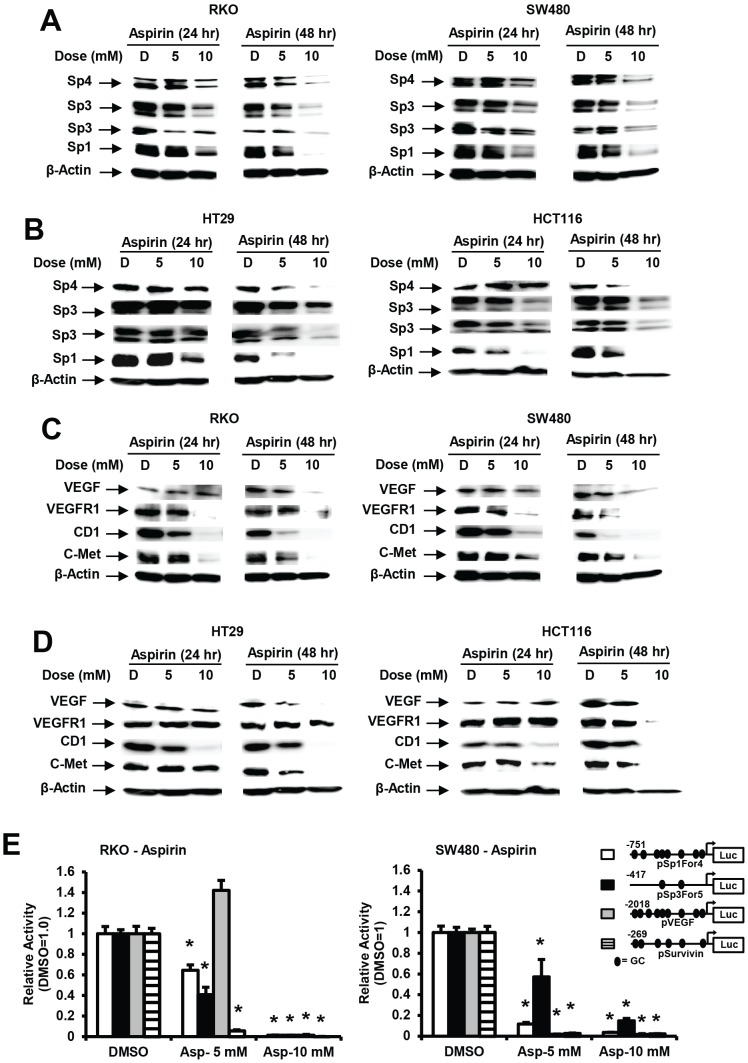
Aspirin decreases expressions of Sp1, Sp3, Sp4 and Sp-regulated gene products in colon cancer cells.Downregulation of Sp proteins in RKO and SW480 (A) and HT29 and HCT116 (B) and Sp-regulated gene products in RKO and SW480 (C) and HT29 and HCT116 (D) cells. Cells were treated with 5 or 10 mM aspirin for 24 or 48 hr, and whole cell lysates were analyzed by western blot analysis as described in the Experimental Procedures. Results are typical of duplicate experiments. (E) Aspirin decreases reporter gene activity. Cells were transfected with pSp1For4, pSp3For5, pVEGF and pSurvivin and treated with DMSO or aspirin (5 or 10 mM). Luciferase activity was determined as described in the Experimental Procedures. Results are expressed as means ± SE (3 replicates) and significant (p<0.05) inhibition is indicated (*).